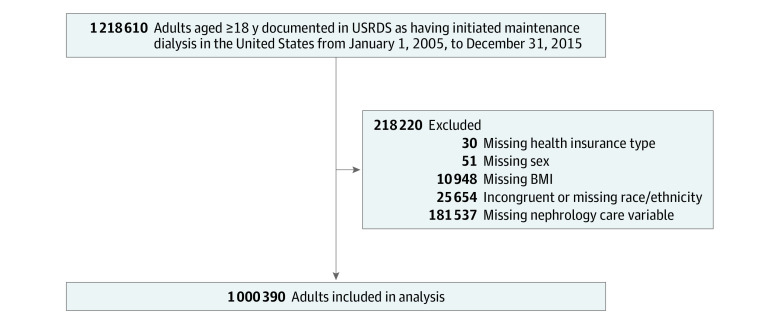
Study Population Flow DiagramBMI indicates body mass index; USRDS, US Renal Data System.